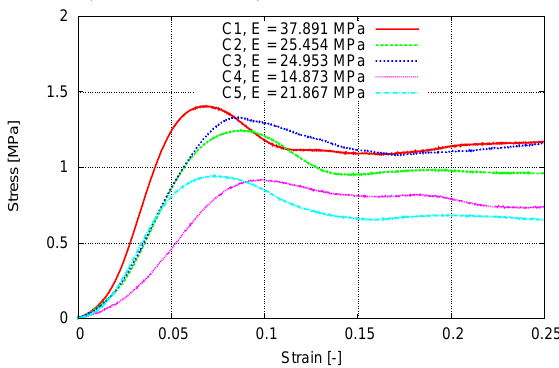
Figure 6. Stress-strain curves of Barium sulphate filler